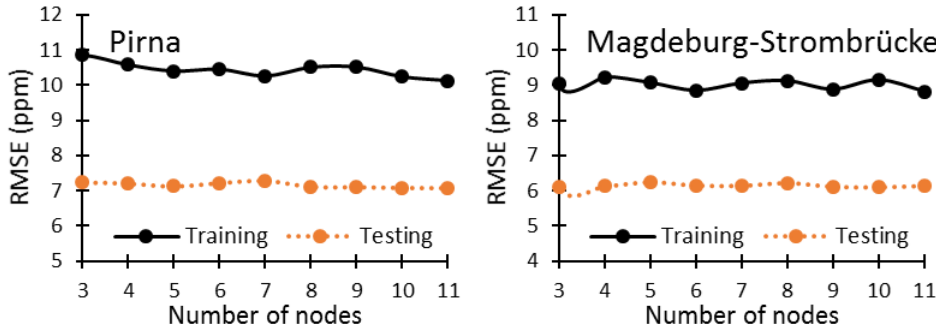
Figure 12. Performance of the ANN model for the increasing number of hidden nodes.